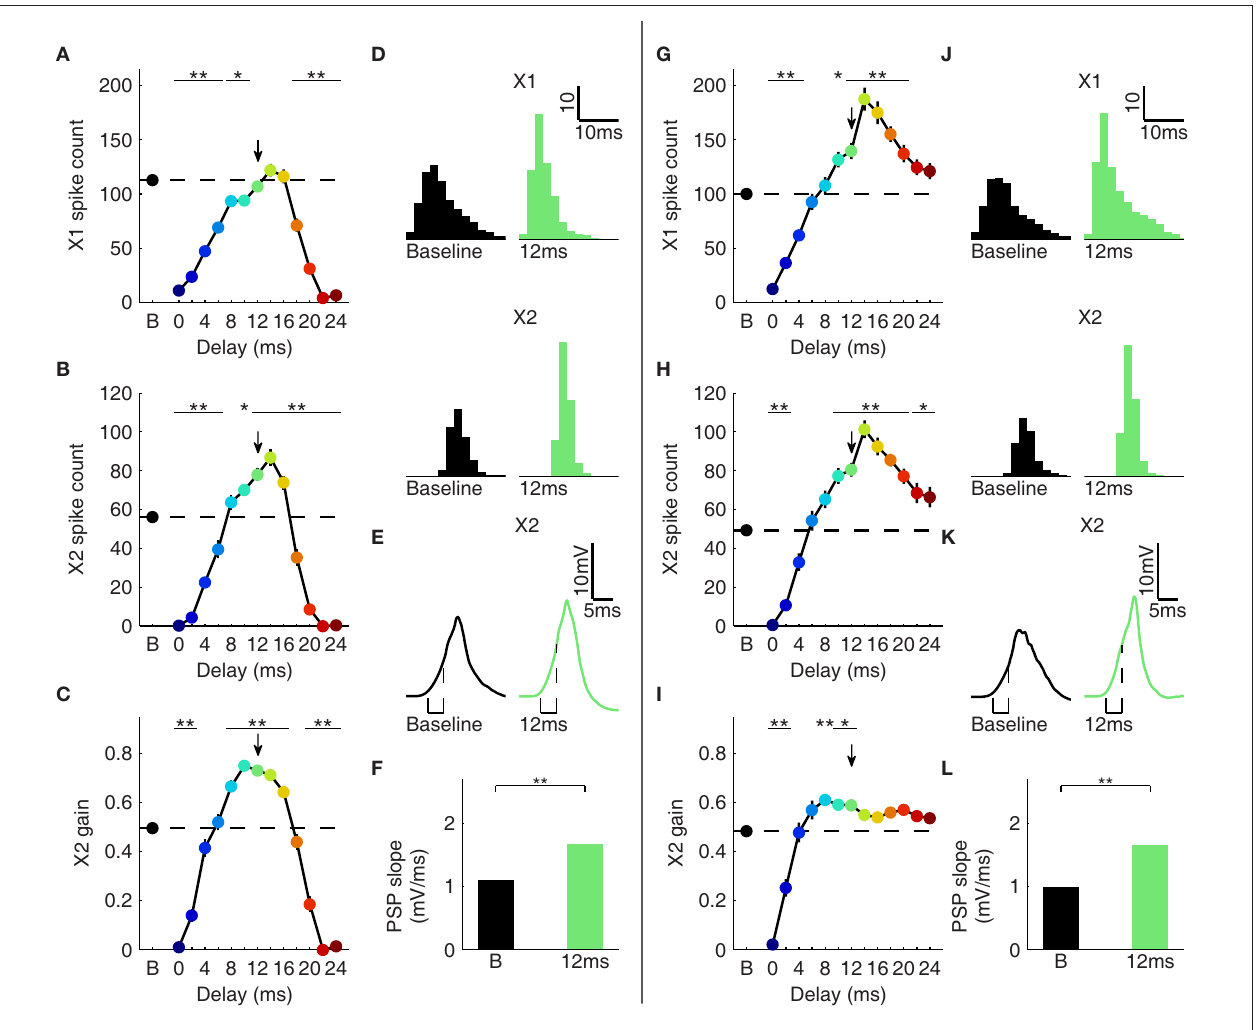
Figure 4 | relationship between X1 spike counts and X2 spike counts and gain. (A) X1 spike counts for repetitive inhibition. (B) X2 spike counts. (C) X2 gain. Arrows in A–C mark the 12-ms delay condition. (D) X2 population responses for FS cells (top) and P cells (bottom) for the baseline (left) and 12-ms